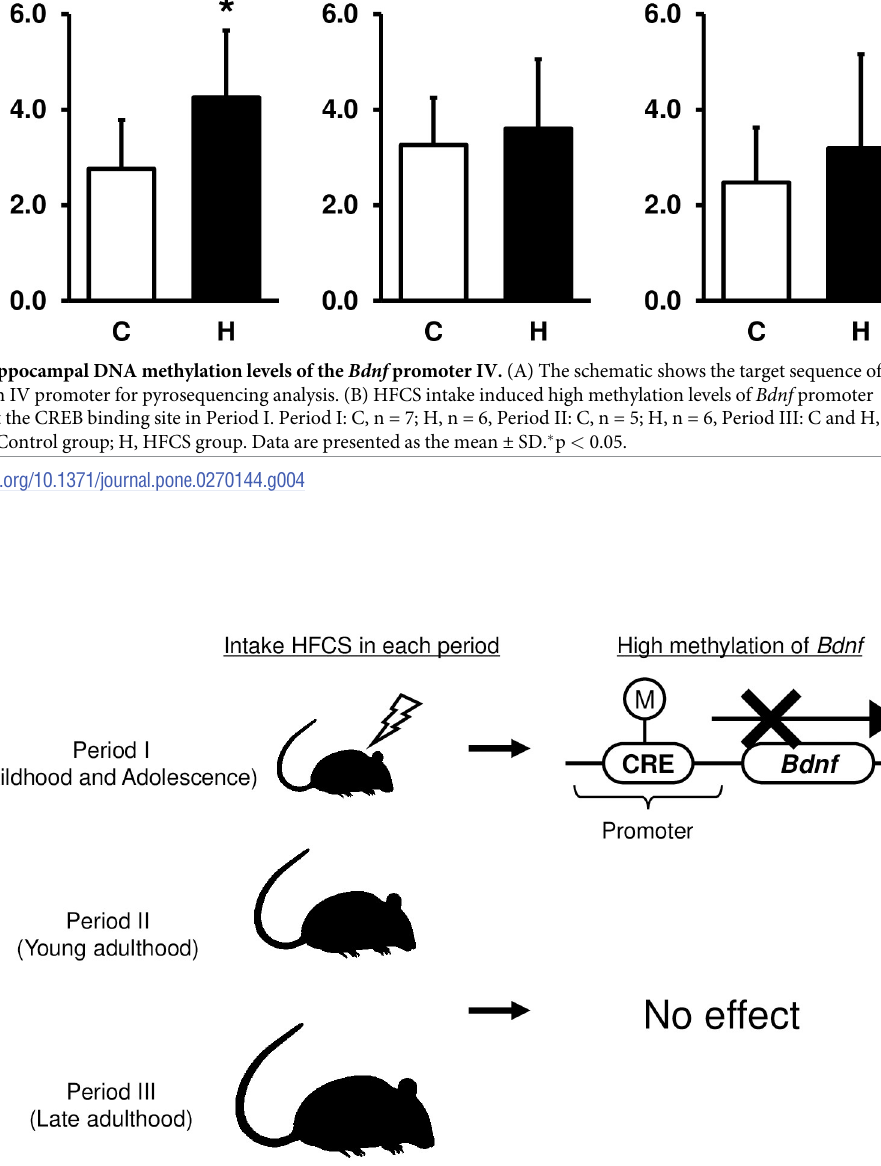
Fig 5. Differences in sensitivity to HFCS consumption in Period I. Excessive HFCS intake induces aberrant DNA methylation of Bdnf promoters in Period I but has no effect on the other periods. This specific change in Period I might cause the downregulation of Bdnf expression and finally hippocampal dysfunction.